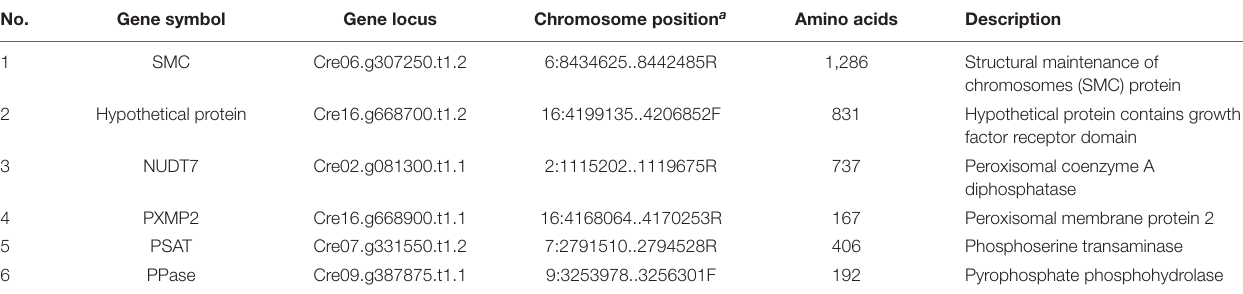
TABLE 1 | List of coding genes of putative interacting proteins of CrPrp19 identified by yeast two-hybrid assay.